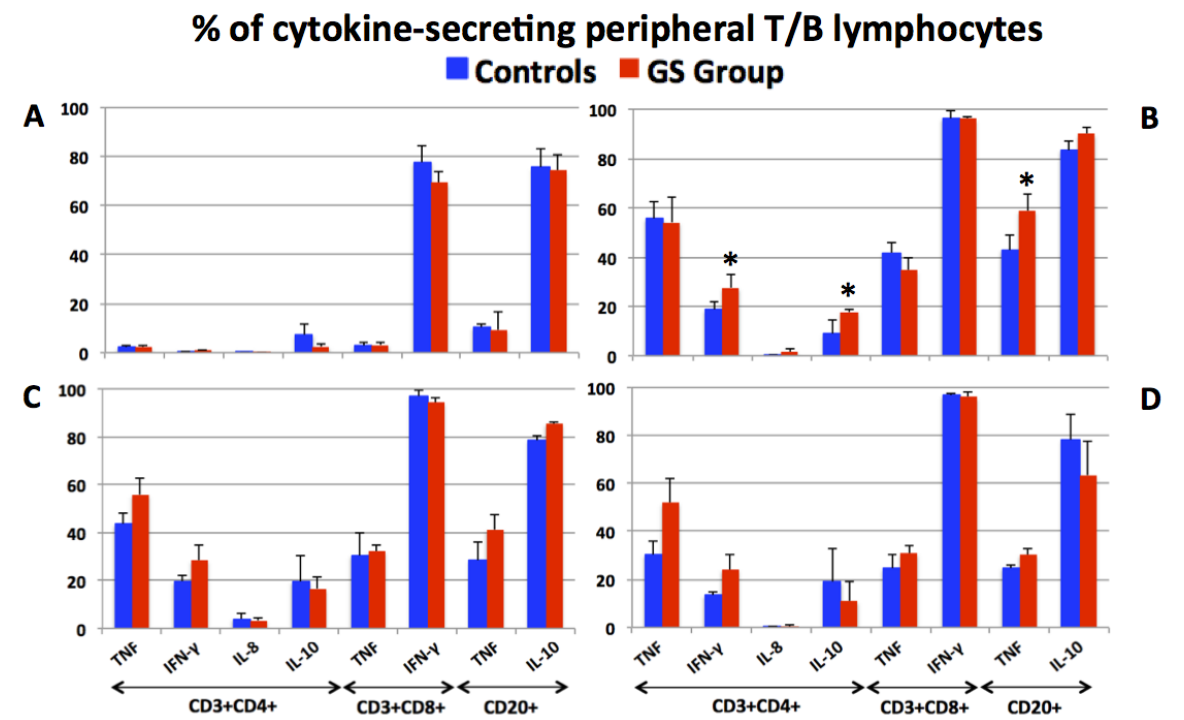
Figure 3. The production of inflammatory (IFN-γ, IL-8 and TNF) and